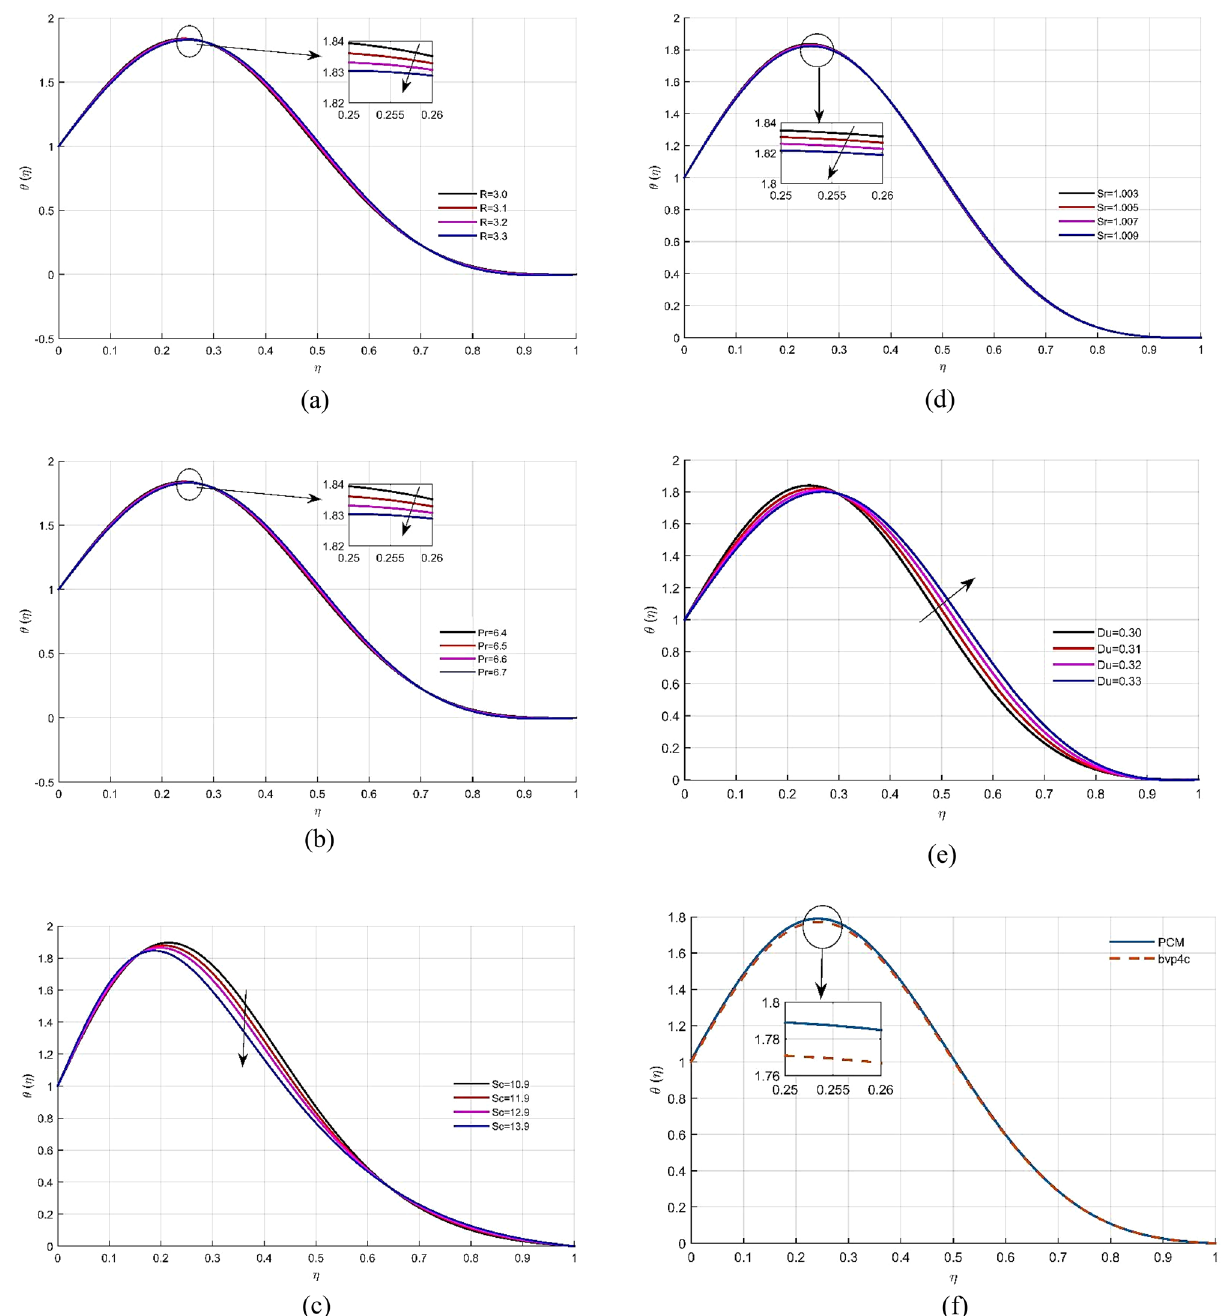
Figure 4. ( a – f ) Variation of dimensionless temperature profile θ(η) with parameters Rd , Pr , Sc , Sr and Du respectively. ( f ) Comparison of solution obtained by PCM and bvp4c